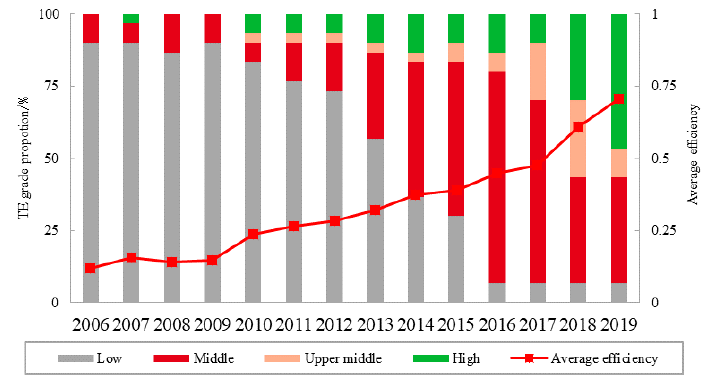
Figure 1. Tourism efficiency mean and grade distribution.